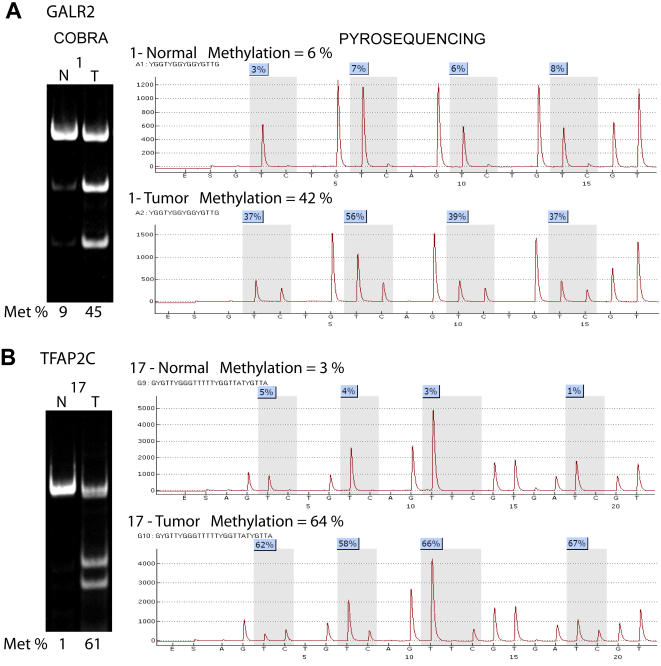
Representative COBRA and pyrosequencing for GALR2 and TFAP2C.For GALR2 and TFAP2C methylation analyses, we used COBRA (left panel) and pyrosequencing (right panel). The methylation density of pyrosequencing is presented in the top of each tracing as the averaged methylation of the CpG sites analyzed. Both methods analyzed almost the same sites in the promoter region as presented in Figure 1. A. In GALR2 methylation analysis, normal adjacent sample showed 9% methylation by COBRA and 6% by pyrosequencing but tumor sample showed 45% by COBRA and 42% by pyrosequencing. B. In TFAP2C methylation analysis, normal sample showed 1% methylation by COBRA and 3% methylation by pyrosequencing but tumor sample showed 61% by COBRA and 64% by pyrosequencing.